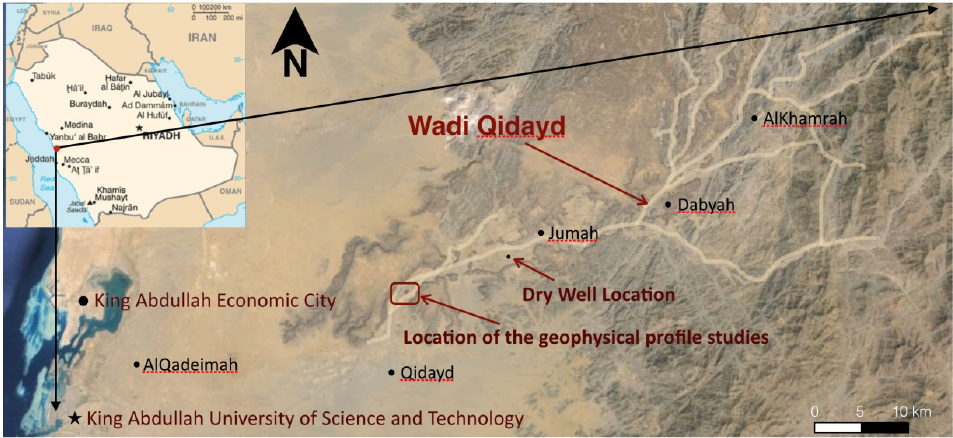
Figure 3. Location of Wadi Qidayd in west-central Saudi Arabia.